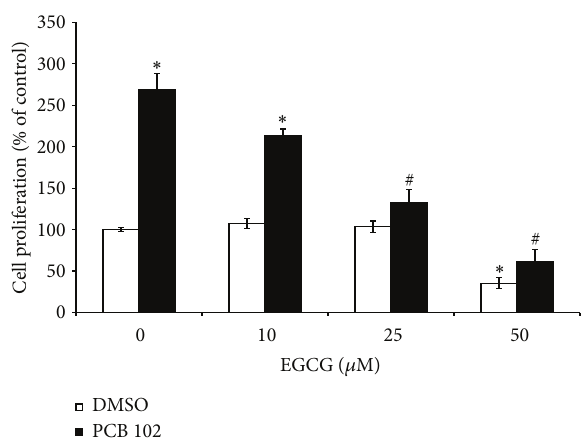
Figure 3: EGCG suppresses PCB 102-induced cell proliferation. MCF-7/BOS cells were treated with 5 𝜇 M PCB 102 alone and in the presence of EGCG (10–50 𝜇 M) for 72 hours. Cell numbers were determined by hemocytometer and expressed as a percentage of the DMSO control (set at 100%). Values are expressed as mean ± SE ( 𝑛 = 3 ). ∗ Significantly different compared to control, 𝑃 < 0.05 ; # significantly different compared to PCB treatment, 𝑃 < 0.05